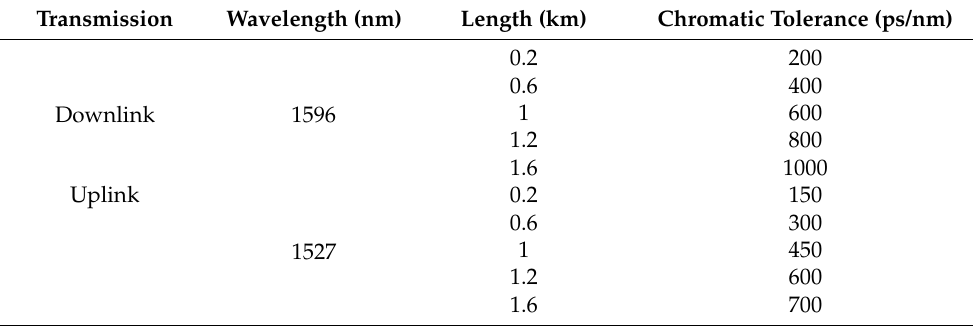
Table 3. Calculated CD for downlink and uplink transmission wavelengths.